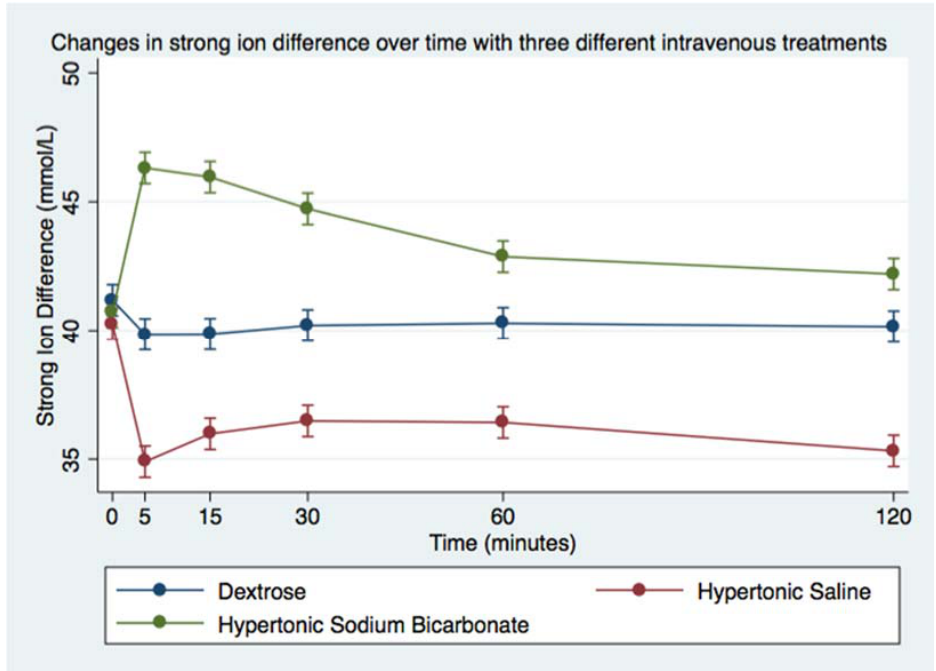
Figure 4. Overall effect of treatment on the blood SID over time. The mean and SEM venous blood SID for all six horses. Blue = Treatment Group DS (5% dextrose solution at 2 mL/kg bwt); Green = Treatment Group HB (NaHCO 3 8.4% solution at 2 mmol/kg bwt); and Red = Treatment Group HS (NaCl 7.5% solution at 4 mL/kg bwt).